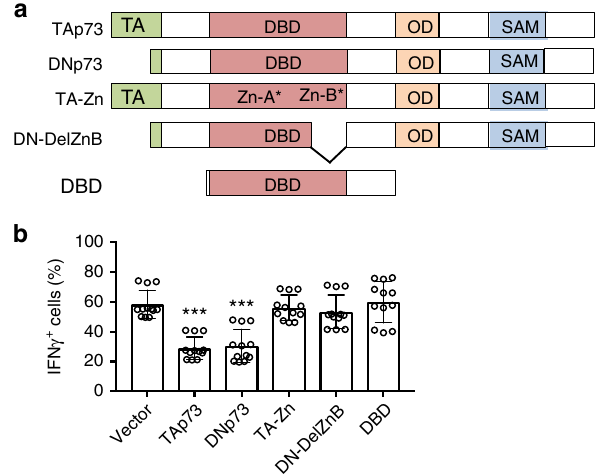
Fig. 2 DNA-binding activity of p73 is required for its inhibitory effect on Th1 differentiation. a Schematic of the domain structure of WT and mutant p73 proteins. The transactivation (TA) domain, DNA-binding domain (DBD), oligomerization domain (OD), and sterile α motif (SAM) are indicated. Mutations in two zinc-binding sites (Zn-A* and Zn-B*) are marked as indicated. b Empty vector or different p73 constructs were overexpressed in Th1 cells via retroviral transduction. IFN γ expression levels were determined by intracellular staining and fl ow cytometric analysis and expressed as the percentage of IFN γ + cells from different p73 mutant- transduced cells (GFP + ). Data represent mean± S.D. from a total of n = 12 biological replicates over four independent experiments. P values of mutant p73 compared to empty vector were determined by two-tailed